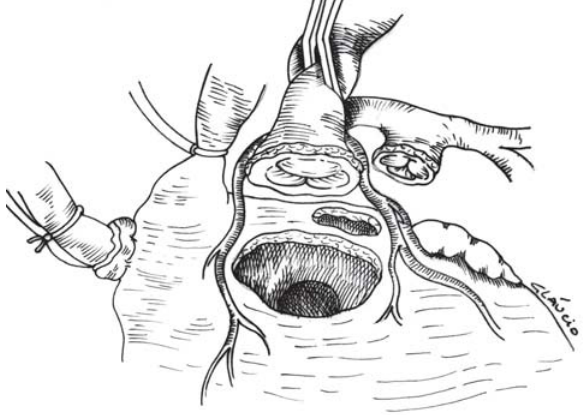
Fig. 1 - Retirada da aorta ascendente com a valva aórtica e as artérias coronárias do ventrículo direito e retirada do tronco